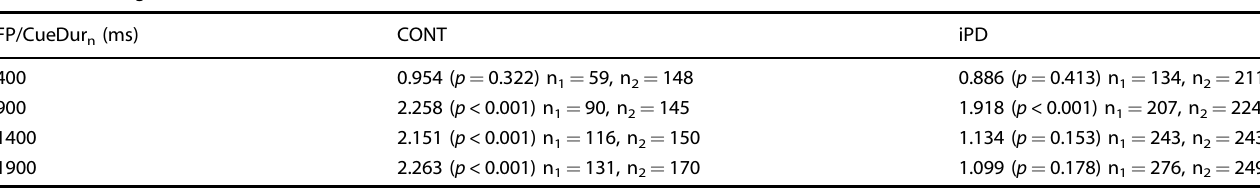
Table 4. Kolmogorov – Smirnov Z